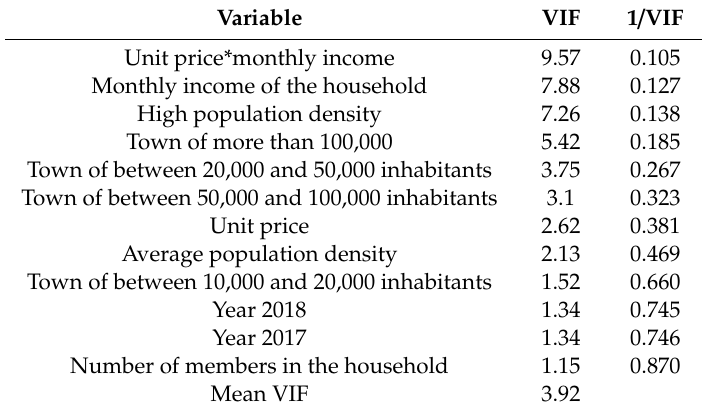
Table A3. Results of the variance inflation factor (VIF) in the consumption model.